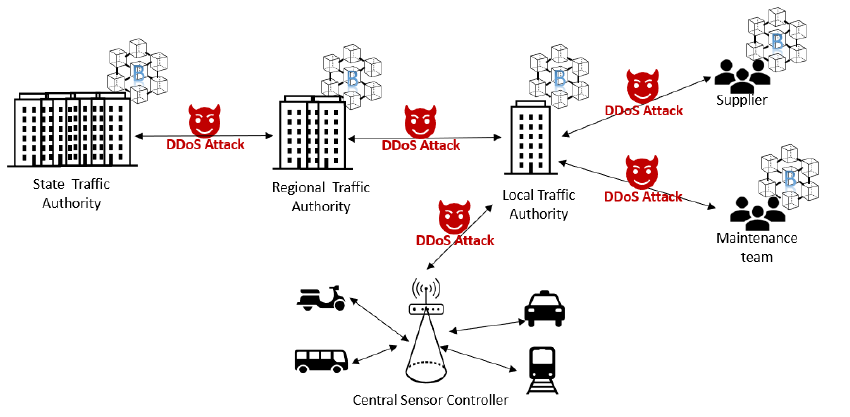
Figure 1. Smart transport